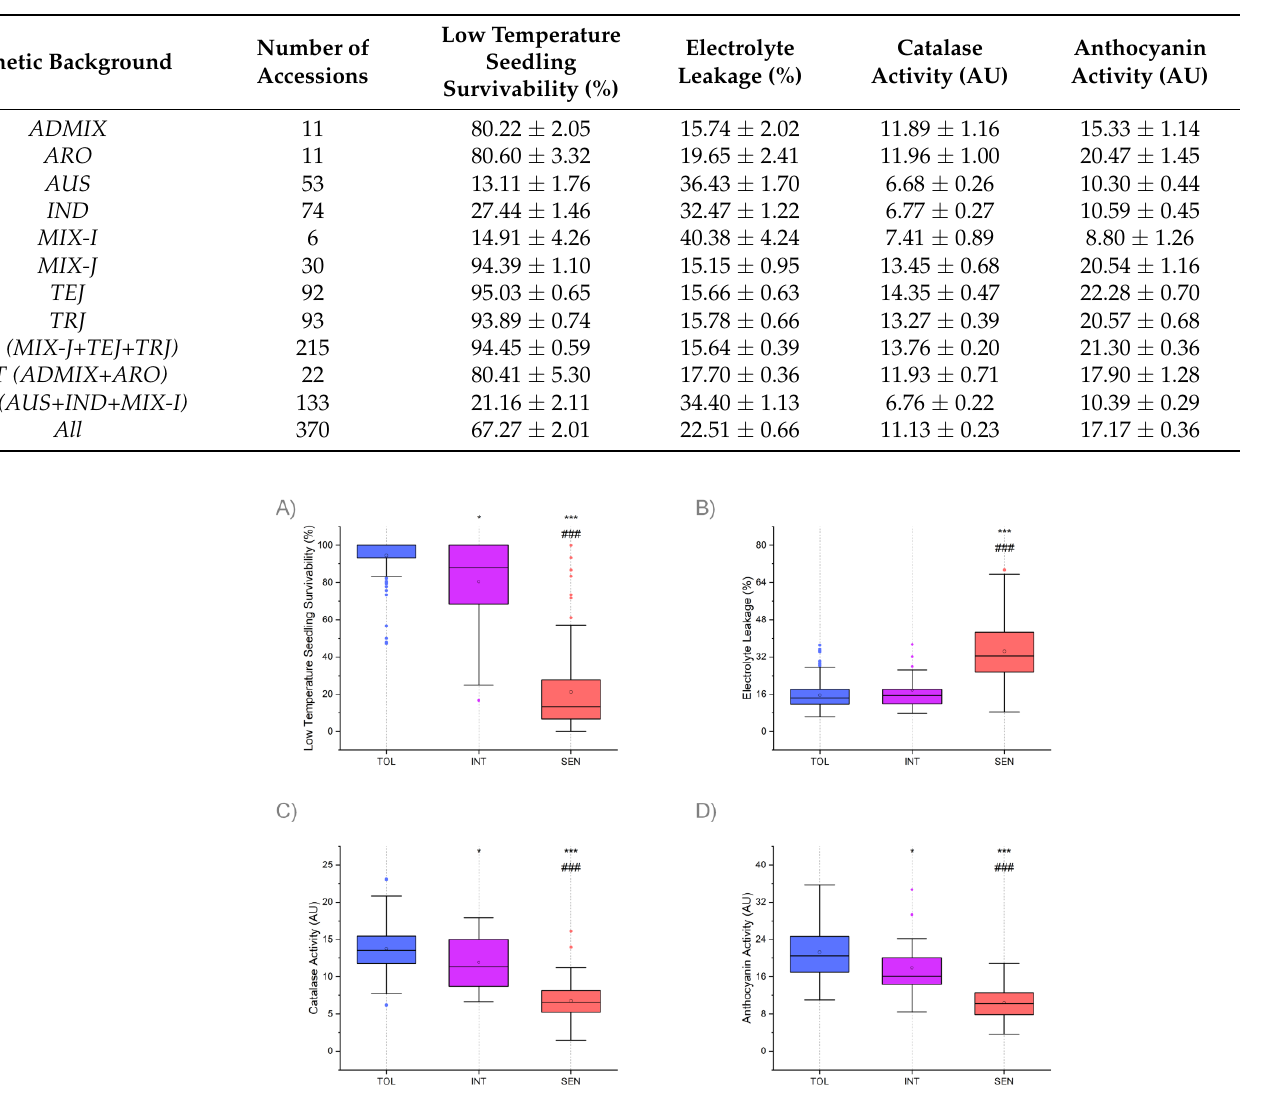
Figure 2. Box plots of mean values for four phenotypes after a 7-day-10 °C chilling treatment for accessions of three cold tolerance clusters (see Figure 1 for details). ( A ) Low Temperature Seedling Survivability (LTSS) values for rice accessions of the three cold tolerance clusters. ( B ) Electrolyte Leakage (EL) values measuring membrane integrity after chilling stress for rice accessions of the three cold tolerance clusters. ( C ) Catalase (CAT) Activity values measuring enzymatic antioxidative activity for rice accessions of the three cold tolerance clusters. ( D ) Anthocyanin (ANT) Activity values measuring non-enzymatic antioxidative activity for rice accessions of the three cold tolerance clusters. TOL: Cold Tolerant; INT: Intermediate Cold Tolerant; SEN: Cold Sensitive. Significant differences compared to the TOL cluster are labeled by the symbol “*”. Significant differences compared to the INT cluster are labeled with the symbol “#”. ***/###: p < 0.001; *: p < 0.05.